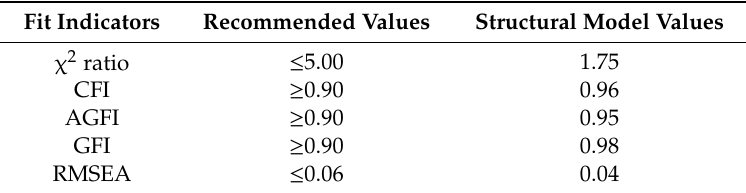
Table 4. Fit statistics for the structural model.